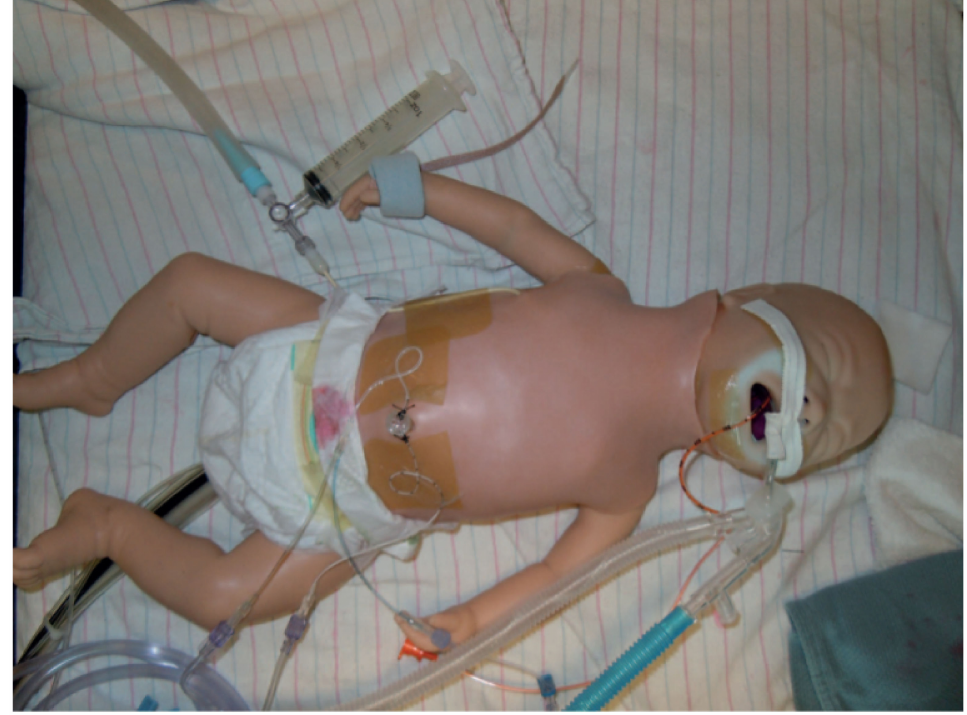
Figure 7. Neonatal ECMO cannulation simulator